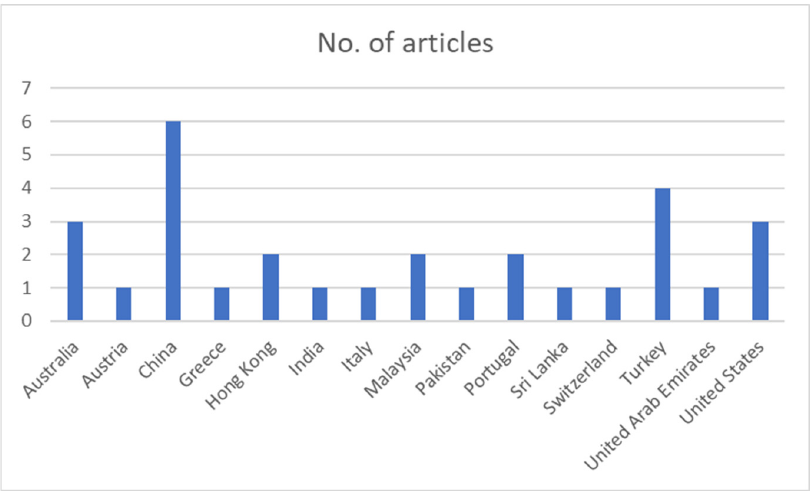
Figure 3. Article distribution among different countries .